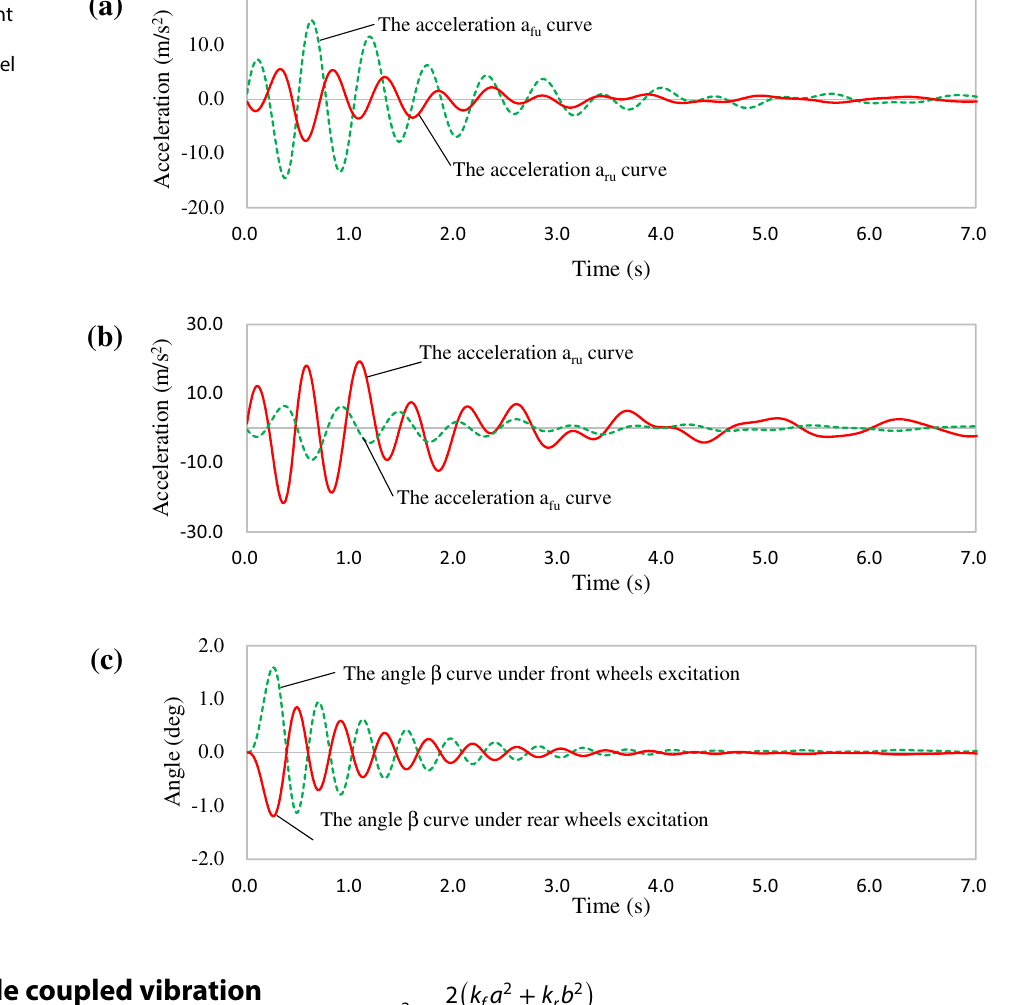
Fig. 3 Vibration test data. a Acceleration data under front wheel excitation. b Accel- eration data under rear wheel excitation. c Pitching angle test